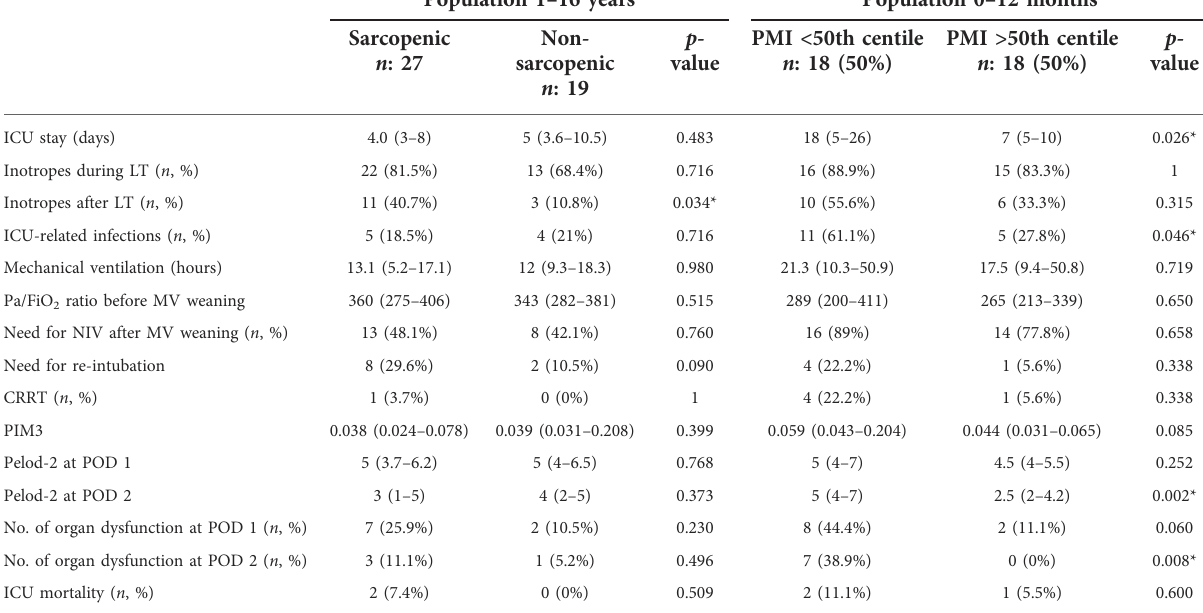
TABLE 3 ICU outcomes in sarcopenic and non-sarcopenic patients.